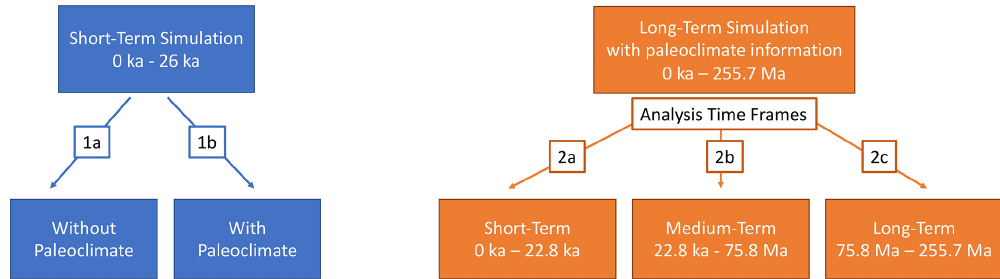
Figure 6. Schematic overview of the transient